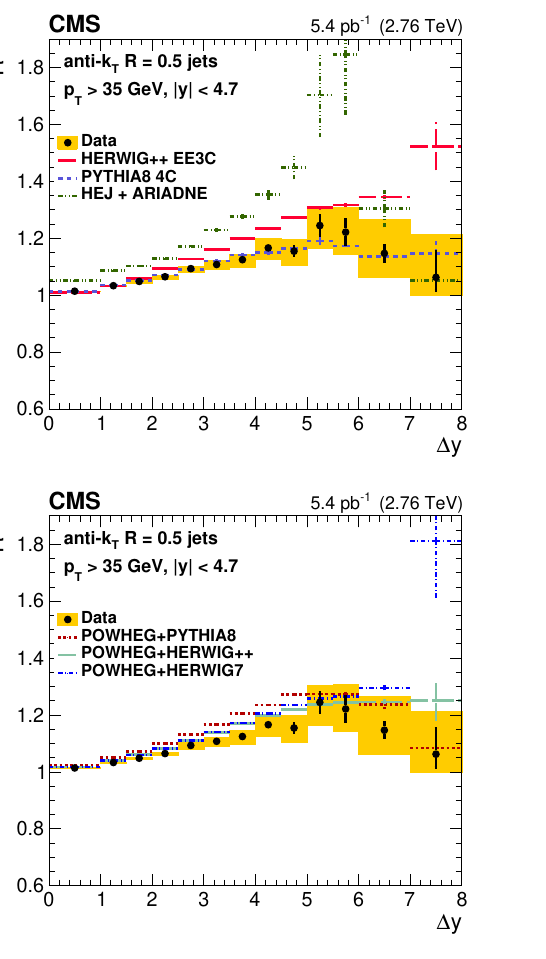
Figure 6 . Ratio R MN of the cross sections for MN to “exclusive” dijet production. The upper and lower rows present the comparison with different MC models. The plots on the left present the ratio R MN and those on the right the ratio of theory to data. The systematic uncertainties are indicated by the shaded bands and the statistical uncertainties by the vertical